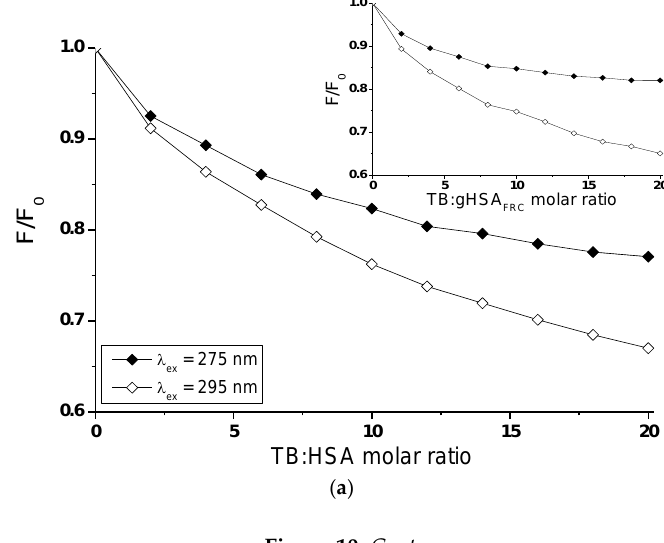
( a ) Figure 10 . Cont. Figure 10.